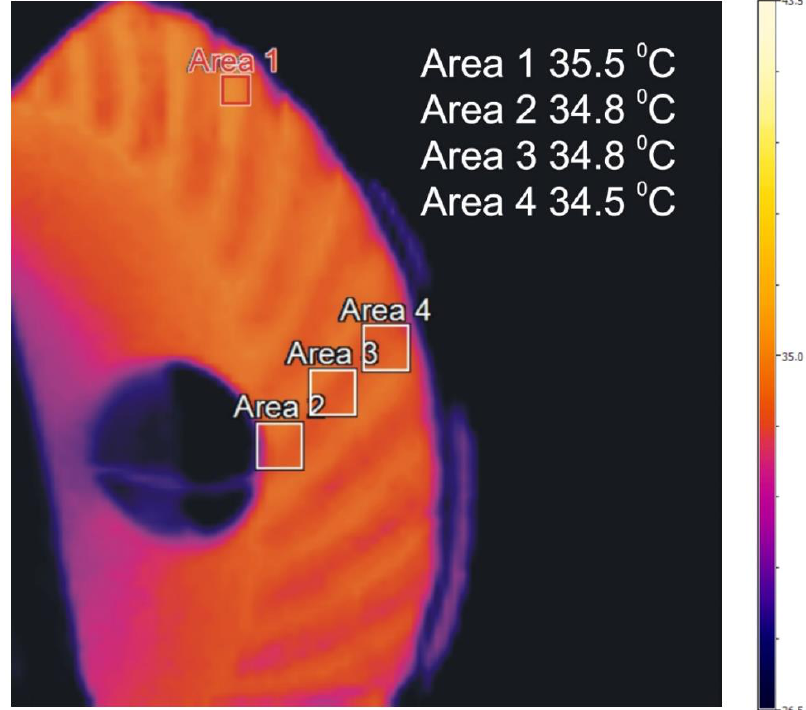
Figure 14. Distribution of temperature in the face gear, measurement number 1.